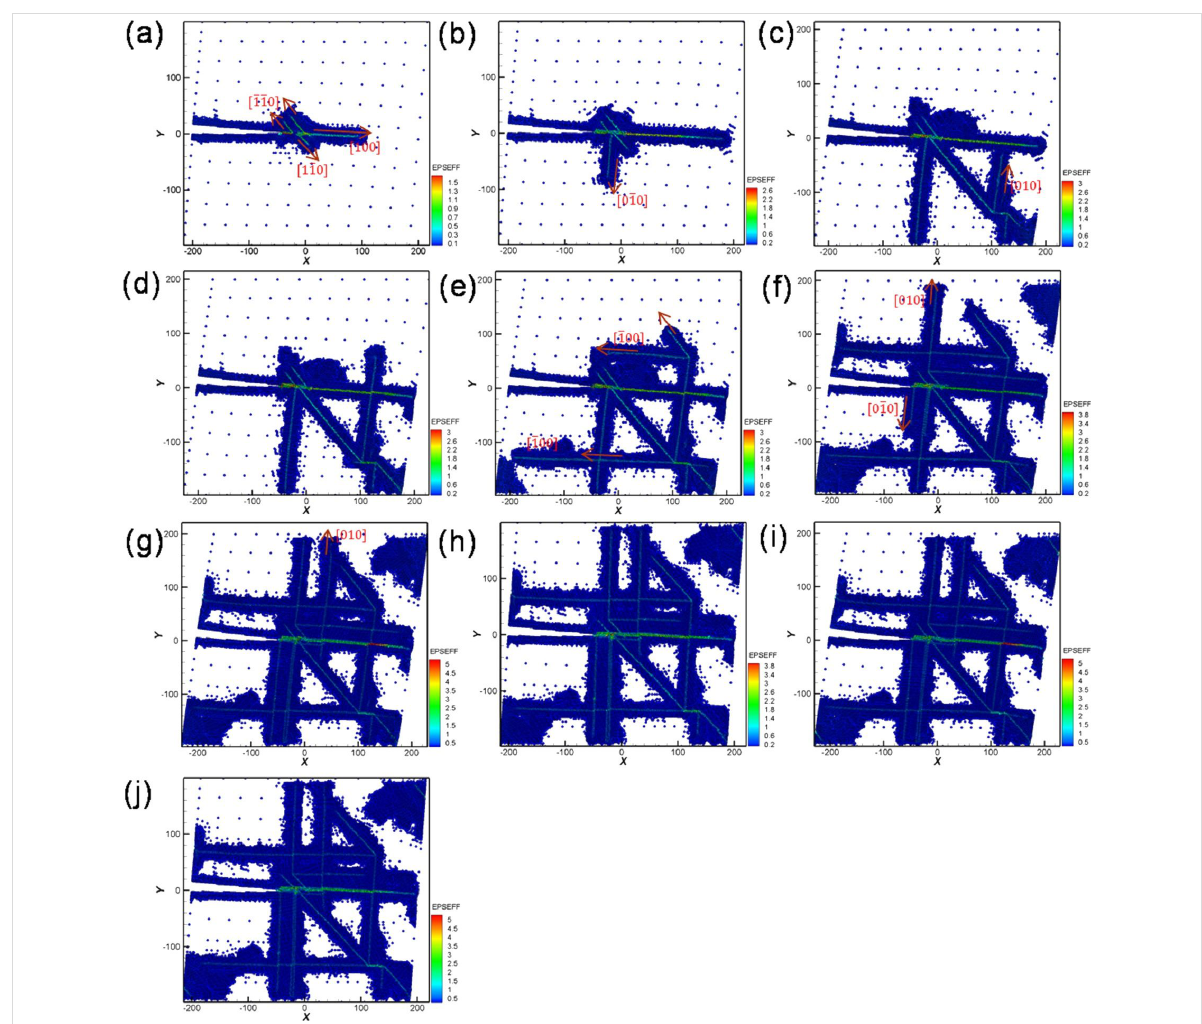
Figure 18: Crack growth and expansion diagrams of Ni along orientation II corresponding to the observation positons a–j in Figure 17.